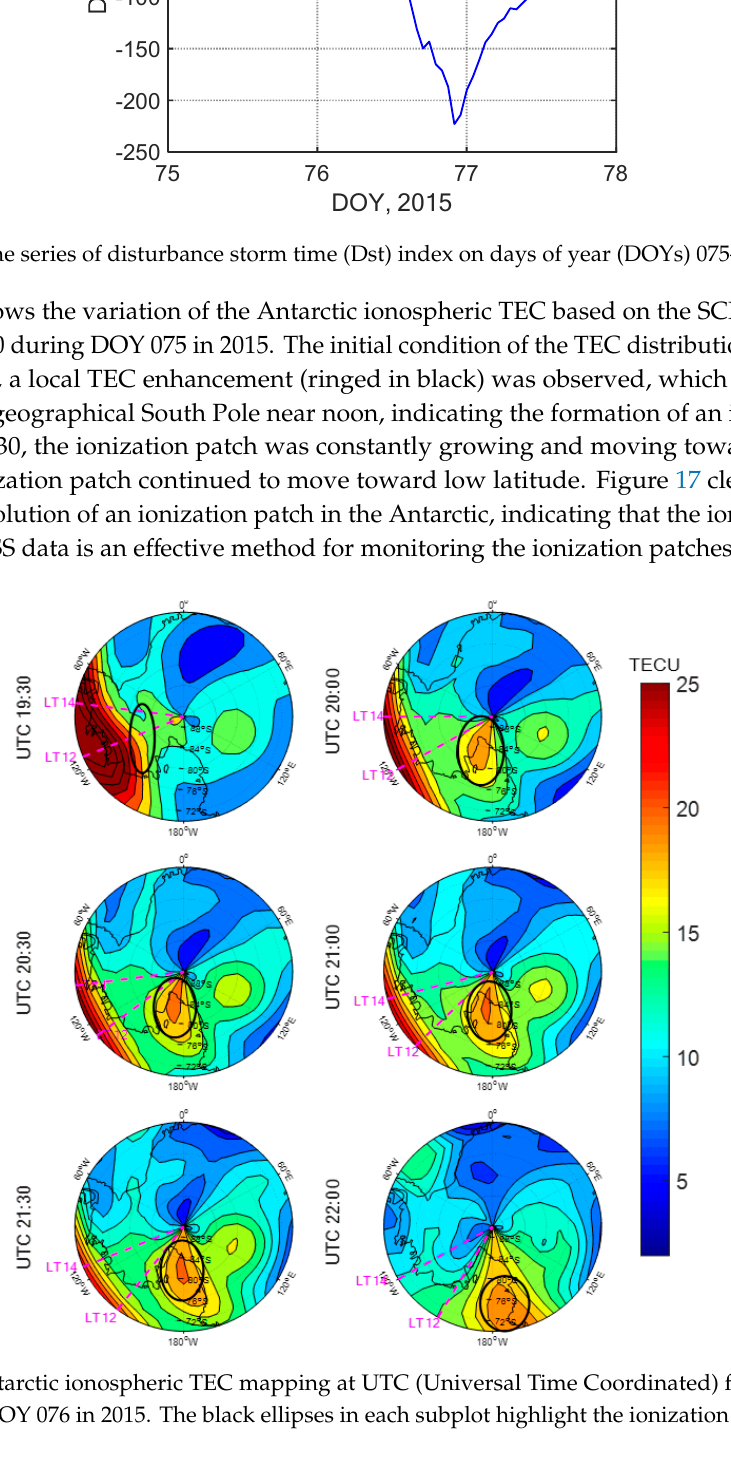
14 of 17 Figure 15. The time series of the C0,0 coefficient with 2 h resolution in March, June, September, and December under low ( top ) and high ( bottom ) solar activity year in the Antarctic. 4.3. Case Study of Tracking Ionization Patches At present, the SuperDARN is often used to track ionization patches [30], but the radar network is sparse and cannot completely cover the polar regions in spatial domain. In addition, based on the SCH model, the evolution of ionization patches in the Arctic has been tracked [12]. In this section, a high-precision regional ionospheric model based on GNSS tracking stations was used to track such